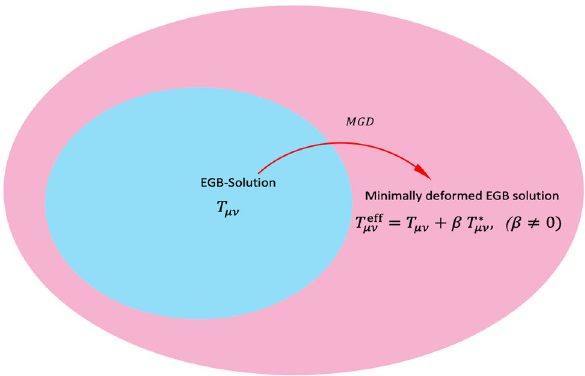
Fig. 1 Schematic diagram of extending the EGB solution via minimal geometric deformation (MGD) approach